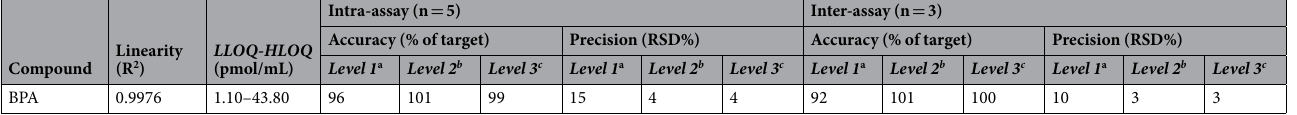
Table 1. Intra-assay and inter-assay validation results. a Level 1: 1.10 pmol BPA/mL, b Level 2: 11.00 pmol BPA/ mL, c Level 3: 43.80 pmol BPA/mL. Abbreviations: LLOQ: lower limit of quantification; HLOQ: higher limit of quantification; RSD: relative standard